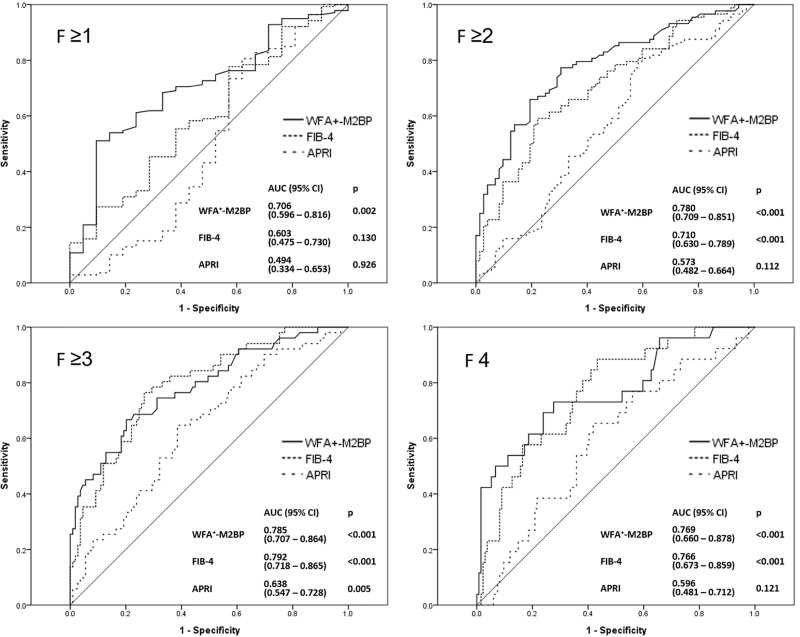
The diagnostic ability of WFA+-M2BP, FIB-4, and APRI in the assessment of fibrosis stage.